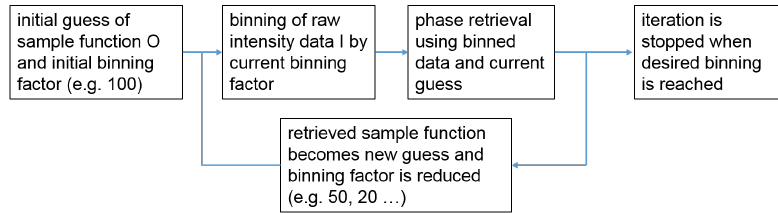
Figure 2. Schematic representation of the algorithm.